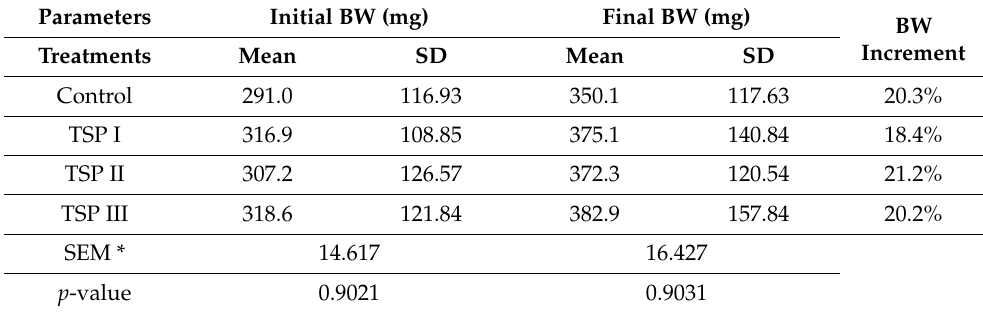
Table 2. Initial and final fish BWs (mg), according to the considered